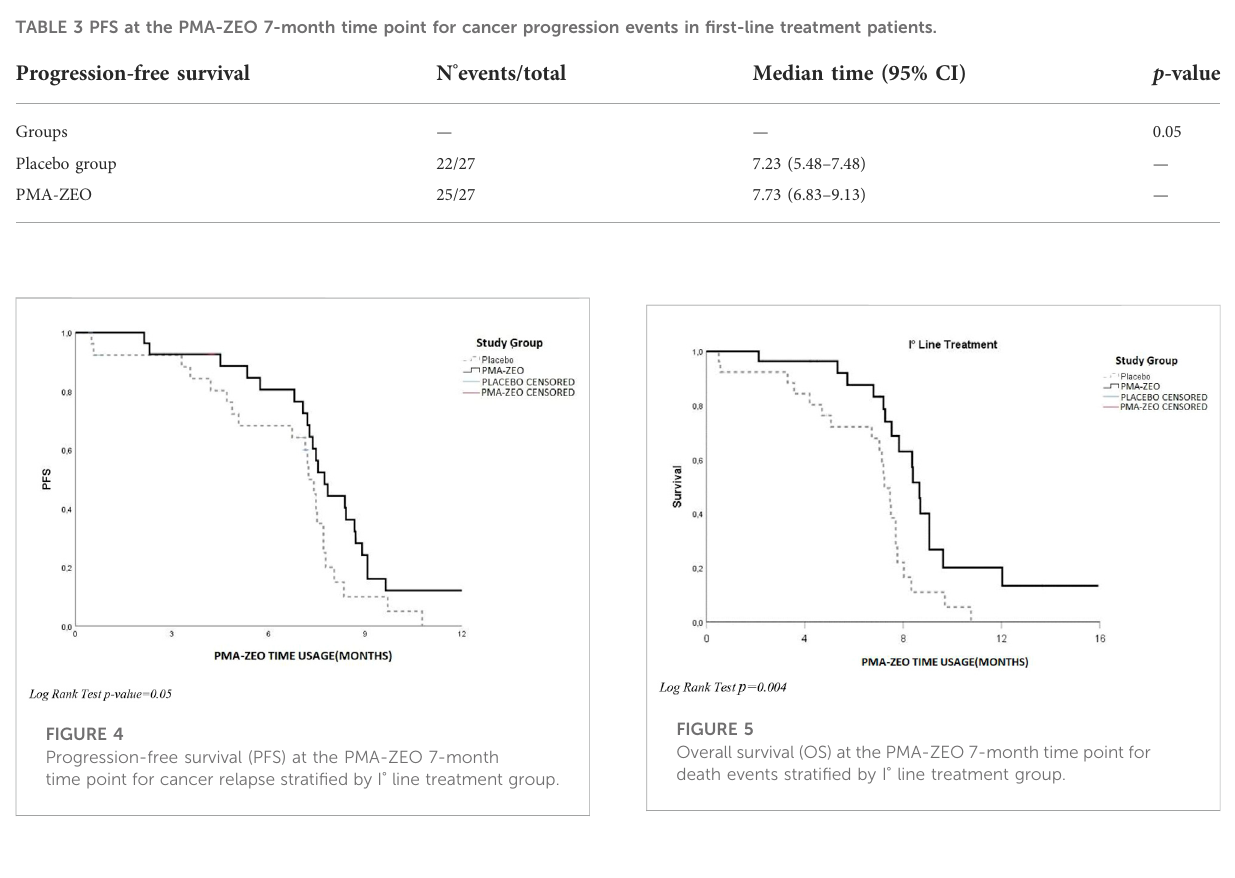
TABLE 4 OS at the PMA-ZEO 7-month time point for death events in fi rst-line treatment patients. Overall survival